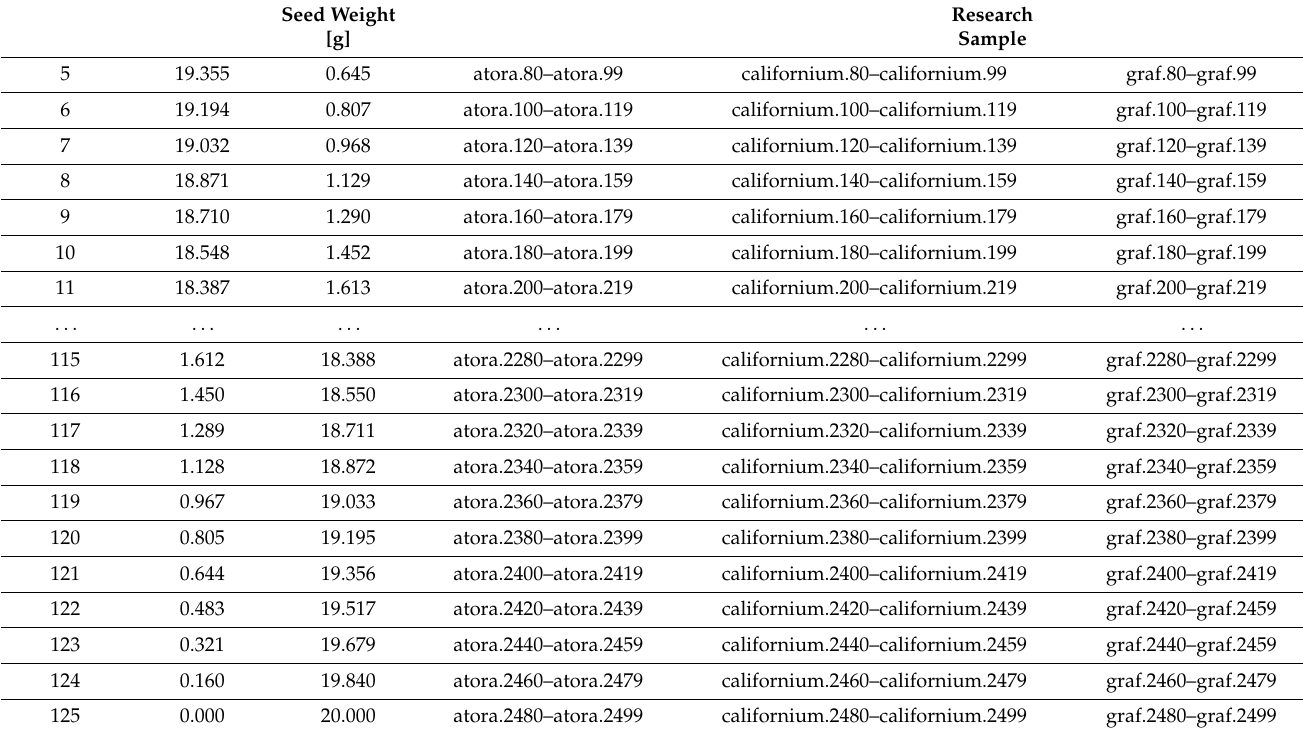
Table 1. Cont. Table 1. Weight group of the imaged three winter rape seed samples (rape and unripe) with the respective weights.